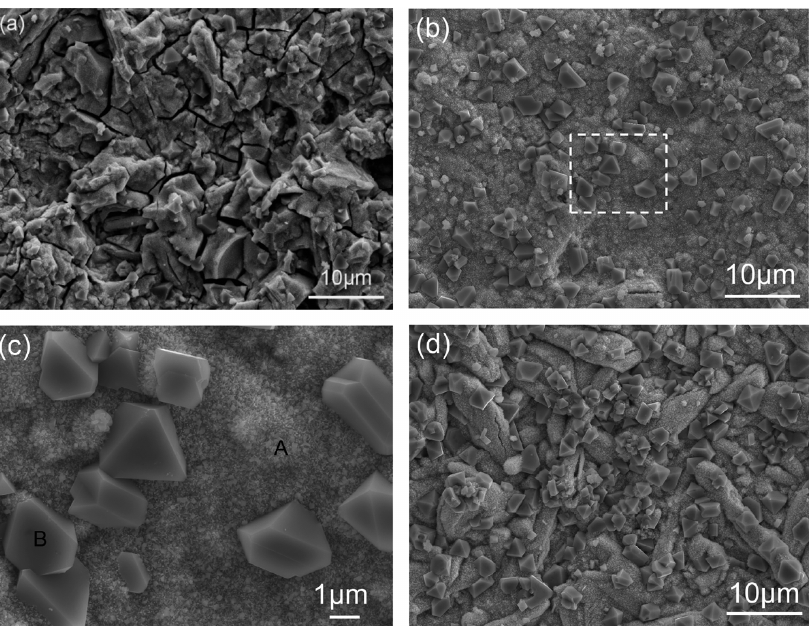
Figure 2: SEM morphologies of the oxide films on 304 stainless steel with (Fe, Cr) Sn 2 adhesion after exposure to 300°C water for various periods (a) 24 h (b) 240 h, low magnification, (c) 240 h, high magnification, (d) 480